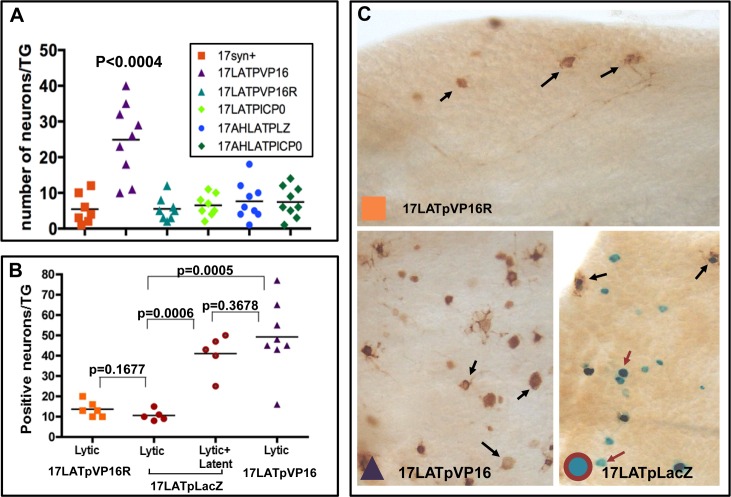
Quantification of the number of neurons expressing the lytic and/or the latent transcriptional program markers.A) Quantification of neurons positive for viral protein at 40 hrs pi. This experiment included 17LATpVP16R, the genomic rescue of 17LATpVP16, as well as 17LATpICP0 and two mutants made on the LAT null background parent 17AH (17AHLATpLacZ and 17AHLATpICP0). There was no significant difference in the number of neurons positive for viral proteins [11] in whole TG except for the TG infected with 17LATpVP16, which contained significantly more positive neurons (p<0.0004, Fisher’s exact test). B) Quantification of neurons positive for viral protein, LATp activity, or both at 46 hrs pi. Each point represents the number of positive neurons in a TG. C) TG were fixed and processed for the simultaneous detection of b-gal activity (blue neurons:red arrows) and viral protein expression (brown neurons:black arrows). Shown are representative photomicrographs of whole ganglia at the same magnification. The number of neurons in TG expressing either viral proteins (lytic), LacZ from the LAT promoter (“latent”), or both (lytic+“latent”) were enumerated (shown in B).